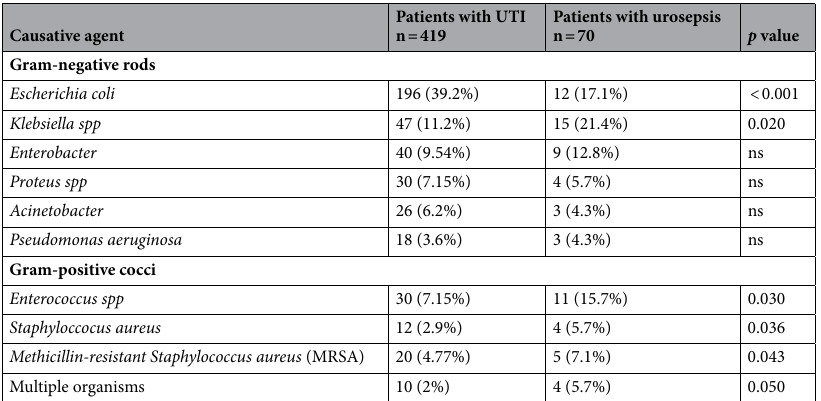
Table 2. Bacterial isolates from urine and blood cultures. ns Non-significant.